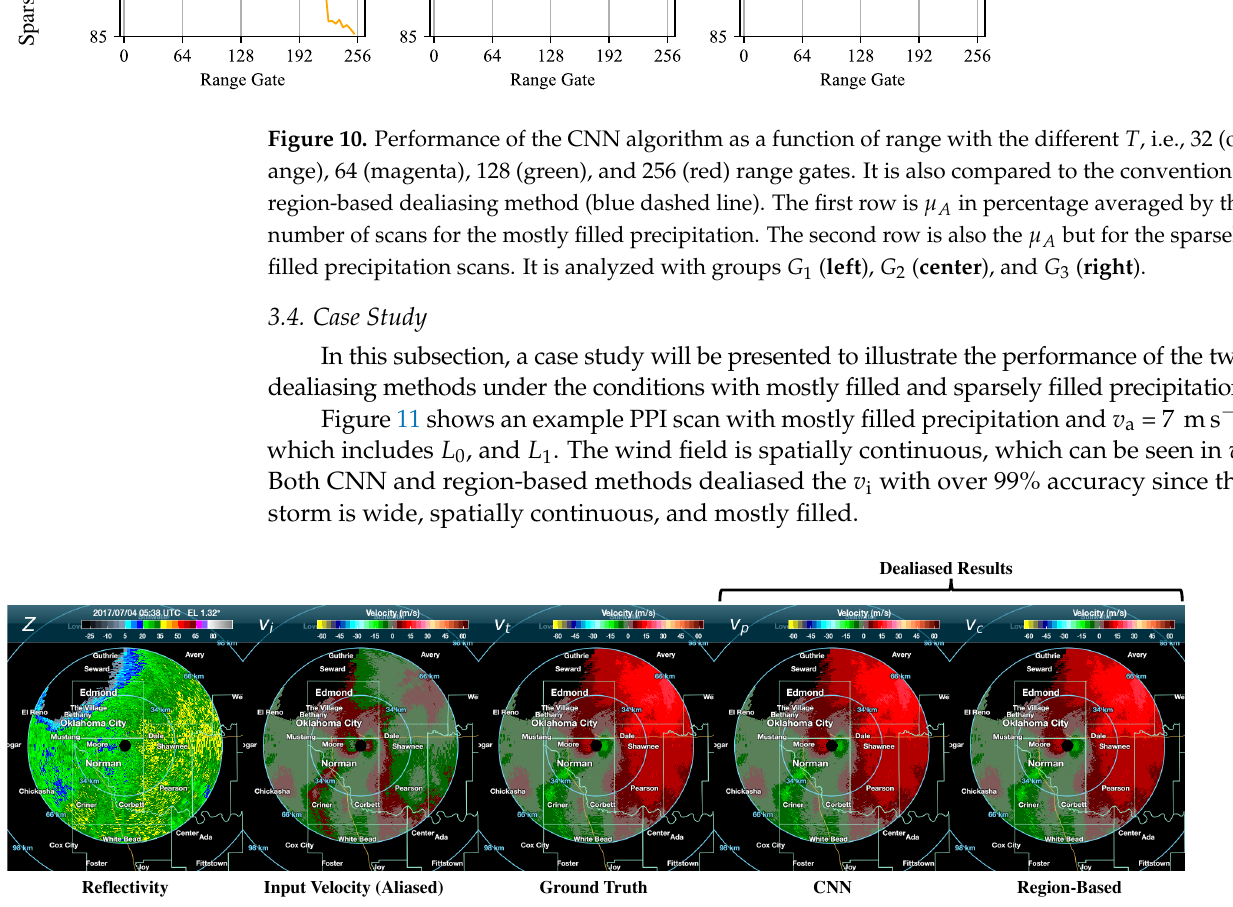
Figure 11. An example PPI scan with a mostly filled precipitation. Z is the reflectivity, v i is the input velocity, v t is the ground truth, v p is the dealiased velocity using the predicted aliased label from the CNN, and v c is the dealiased velocity using the conventional region-based dealiasing method. The data are synthesized using a 1.32 ◦ -EL scan from the KTLX on 4 July 2017 05:38 UTC. This example shows the result of processing a velocity field observed at 7 ms − 1 . For most simple cases such as this, both methods are able to produce an accurate dealiased velocity field. This example shows over 99% accuracy from both CNN and region-based